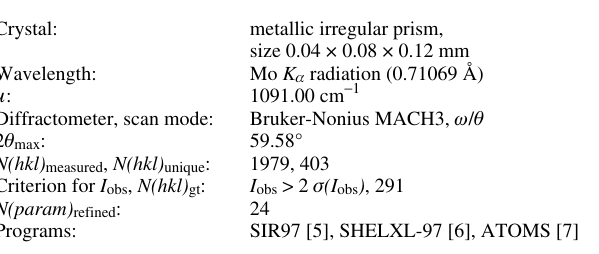
Table 1. Data collection and